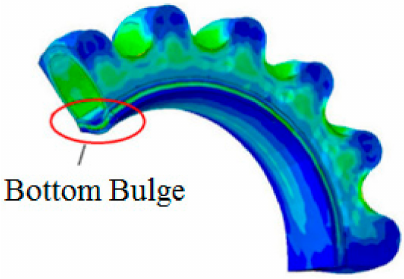
Figure 11. Simulation diagram of the bottom bulge of the soft actuator.